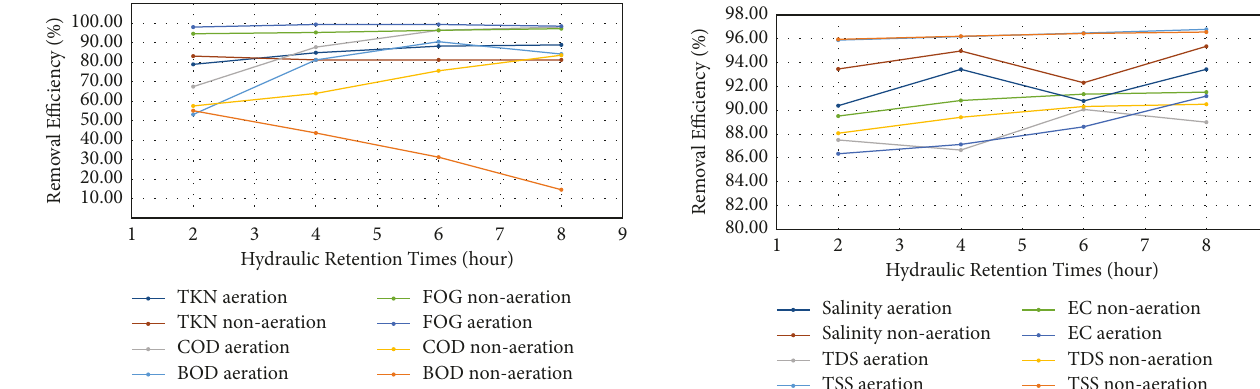
Figure 5: Removal efficiencies of TSS, TDS, EC, and salinity in aeration and nonaeration HSFCWs systems.